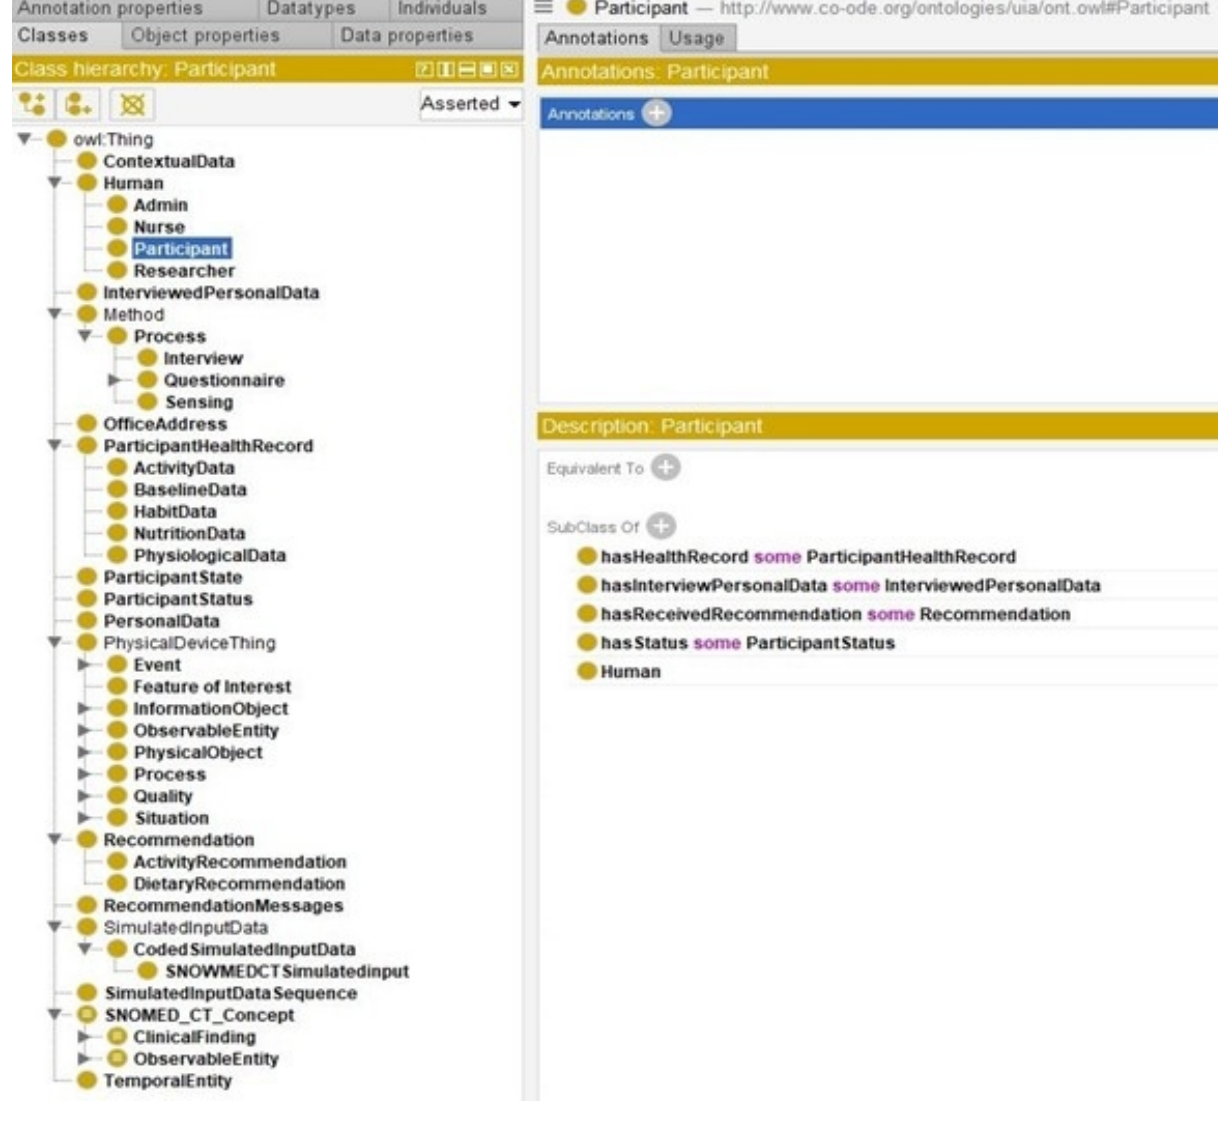
Figure 11. The class hierarchy of the proposed eHealth ontology and the description of participant